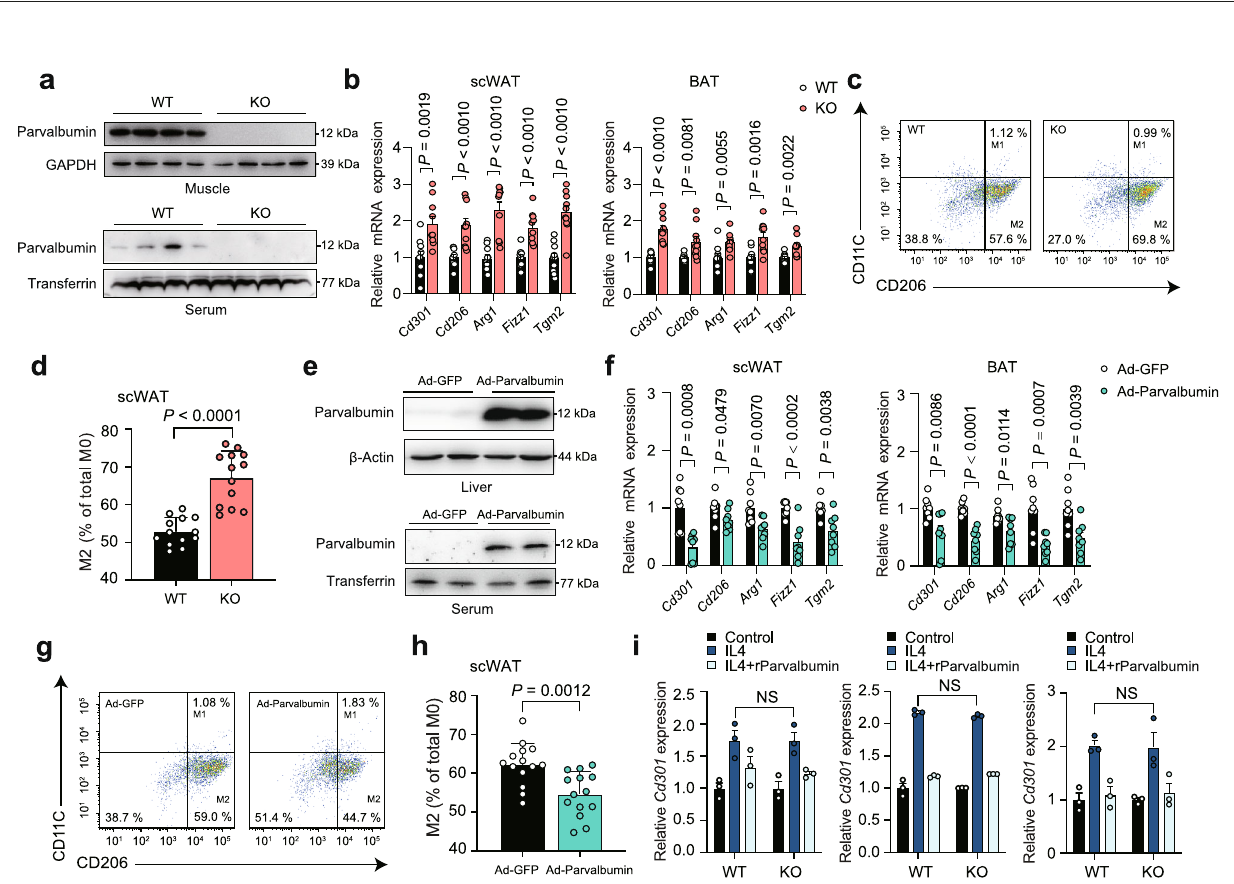
Fig. 1 Identi fi cation of parvalbumin as an Exercise-suppressed regulator of M2 macrophage. Representative M1 and M2 macrophage marker gene expression in scWAT ( a ) and BAT ( b ) of sedentary and exercised mice. Sedentary, n = 6; exercise, n = 6. c Volcano plot of secreted proteins altered in serum from treadmill-running mice compared with sedentary controls ( n = 3 with 3 mouse serums per pool). Multiple hypothesis correction were performed on the data and q-value was used to replace p-values. d Parvalbumin protein levels in muscle and adipose tissues. e Parvalbumin protein levels in serum from exercised or sedentary mice. Representative M1 ( f ) ( P value: 0.016, <0.0001, <0.0001, 0.0307, <0.0001, <0.0001, 0.0003, <0.0001) and M2 ( g ) ( P value: *** p < 0.0001) macrophage marker gene expression in BMDM exposed to indicated concentration of parvalbumin ( n = 6 per group). h Flow cytometric analysis of M2 macrophage marker CD206 in BMDM treated with or without parvalbumin ( n = 6 per group). P value: *** p < 0.0001. i Cell viability and ( j ) Caspase 3/7 activity in BMDMs treated with or without parvalbumin (100 ng/ml) ( n = 5 per group). k Representative M2 macrophage marker gene expression in human PBMCs treated with or without human parvalbumin (100 ng/ml) ( n = 3 per group). P value: 0.0346, 0.0003, 0.0005, 0.0002. n values refer to the number of mice and human serum samples used. Data are represented as mean ± SEM. P values were determined by unpaired two-tailed Student ’ s t -test a , b , c and i – k or one-way ANOVA with Tukey ’ s post hoc tests ( f – h ). * p < 0.05, ** p < 0.01, *** p < 0.001. Source data are provided as a Source Data fi le.